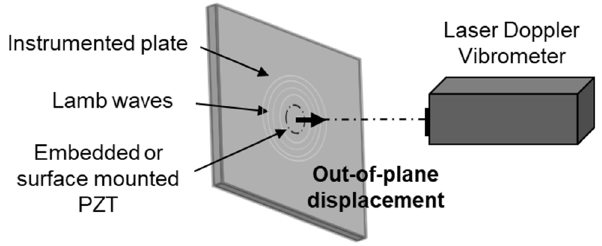
Figure 8. A schematic of a laser Doppler vibrometer bench used to measure the out-of-plane dis- placement generated by an embedded or surface-mounted PZT. ment generated by an embedded or surface-mounted